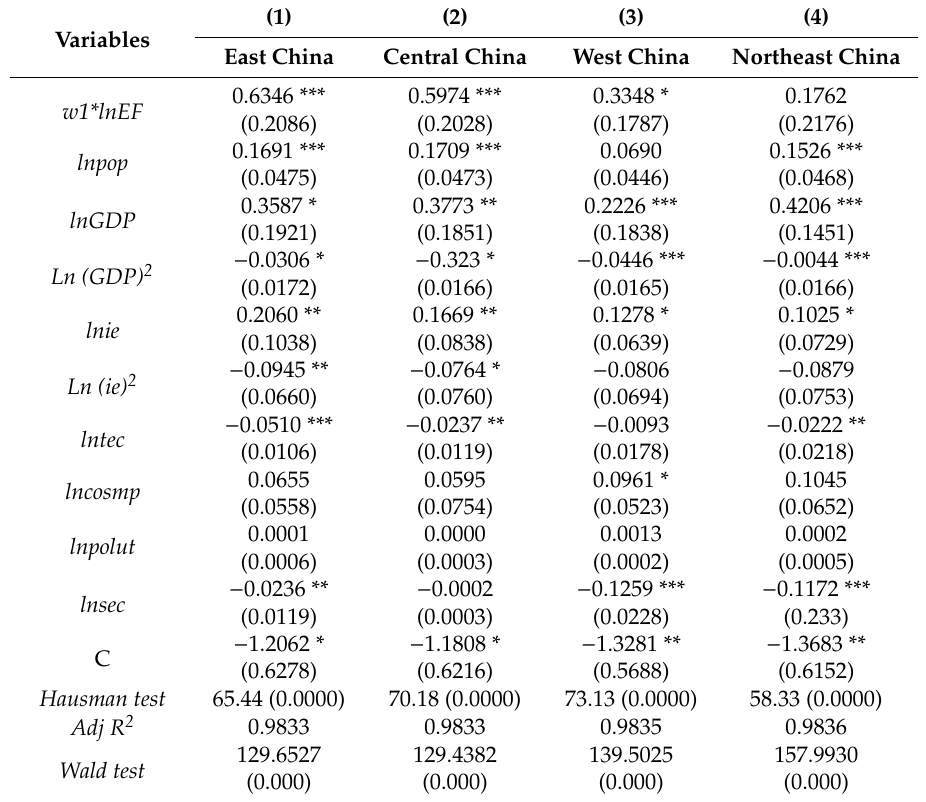
Table 4. Regression results for the four